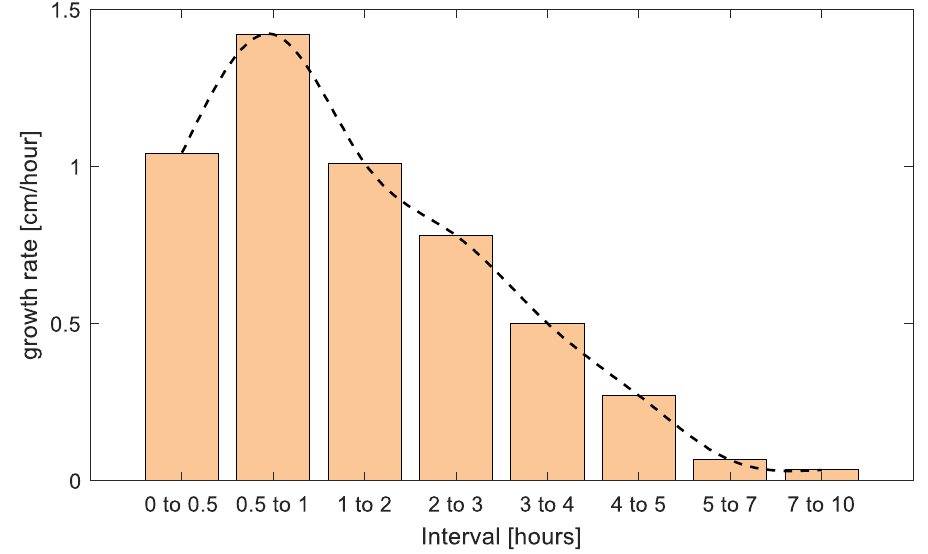
Figure 6. The growth rate of a sand wave as a function of time.